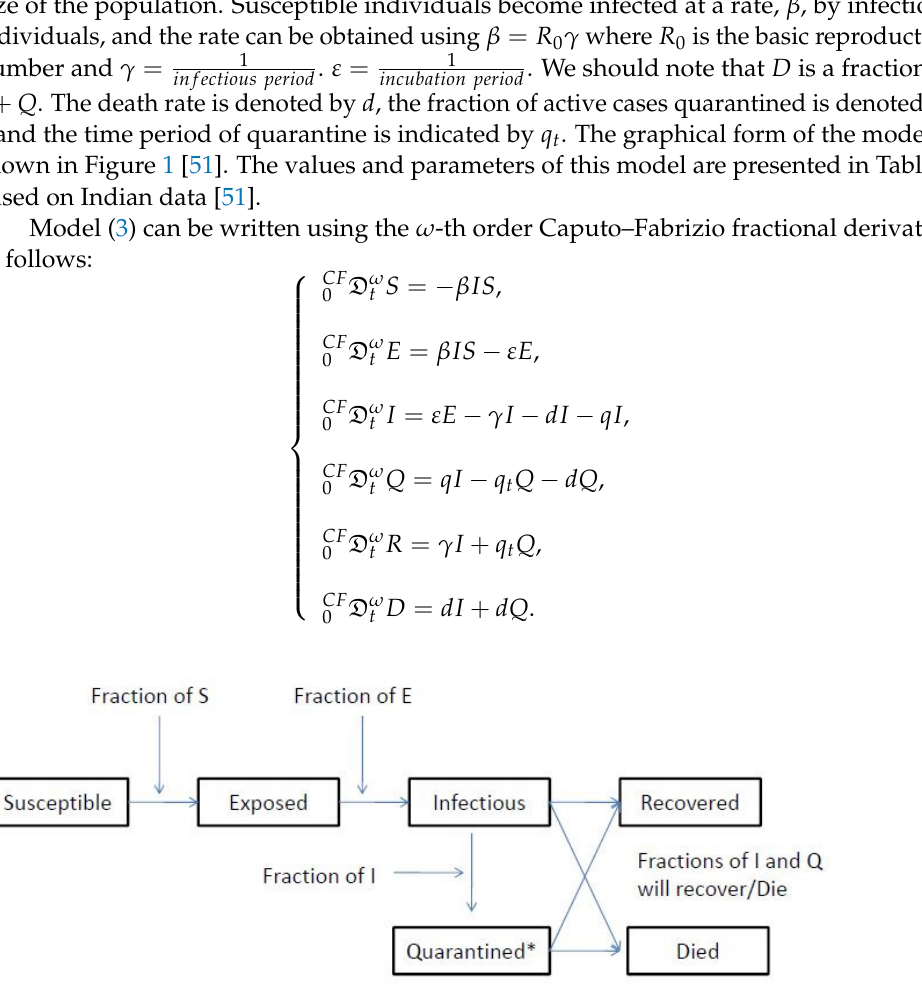
Figure 1. The model of COVID-19